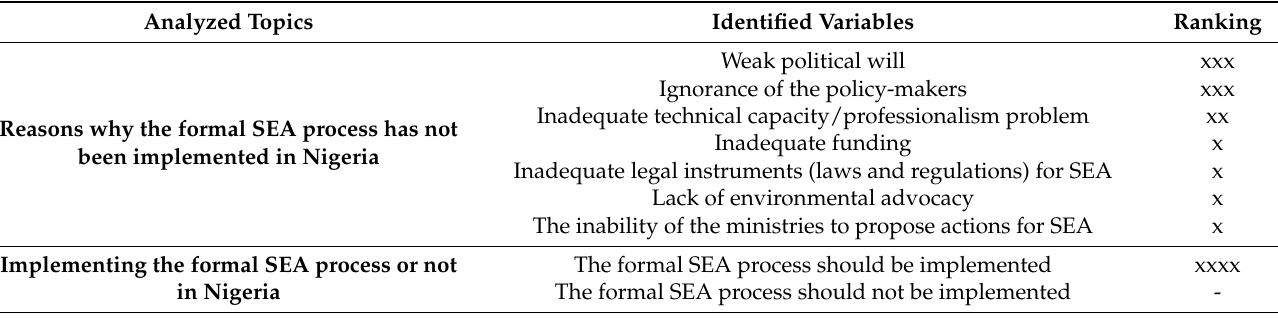
Table 7. Implementing the SEA process in Nigeria.